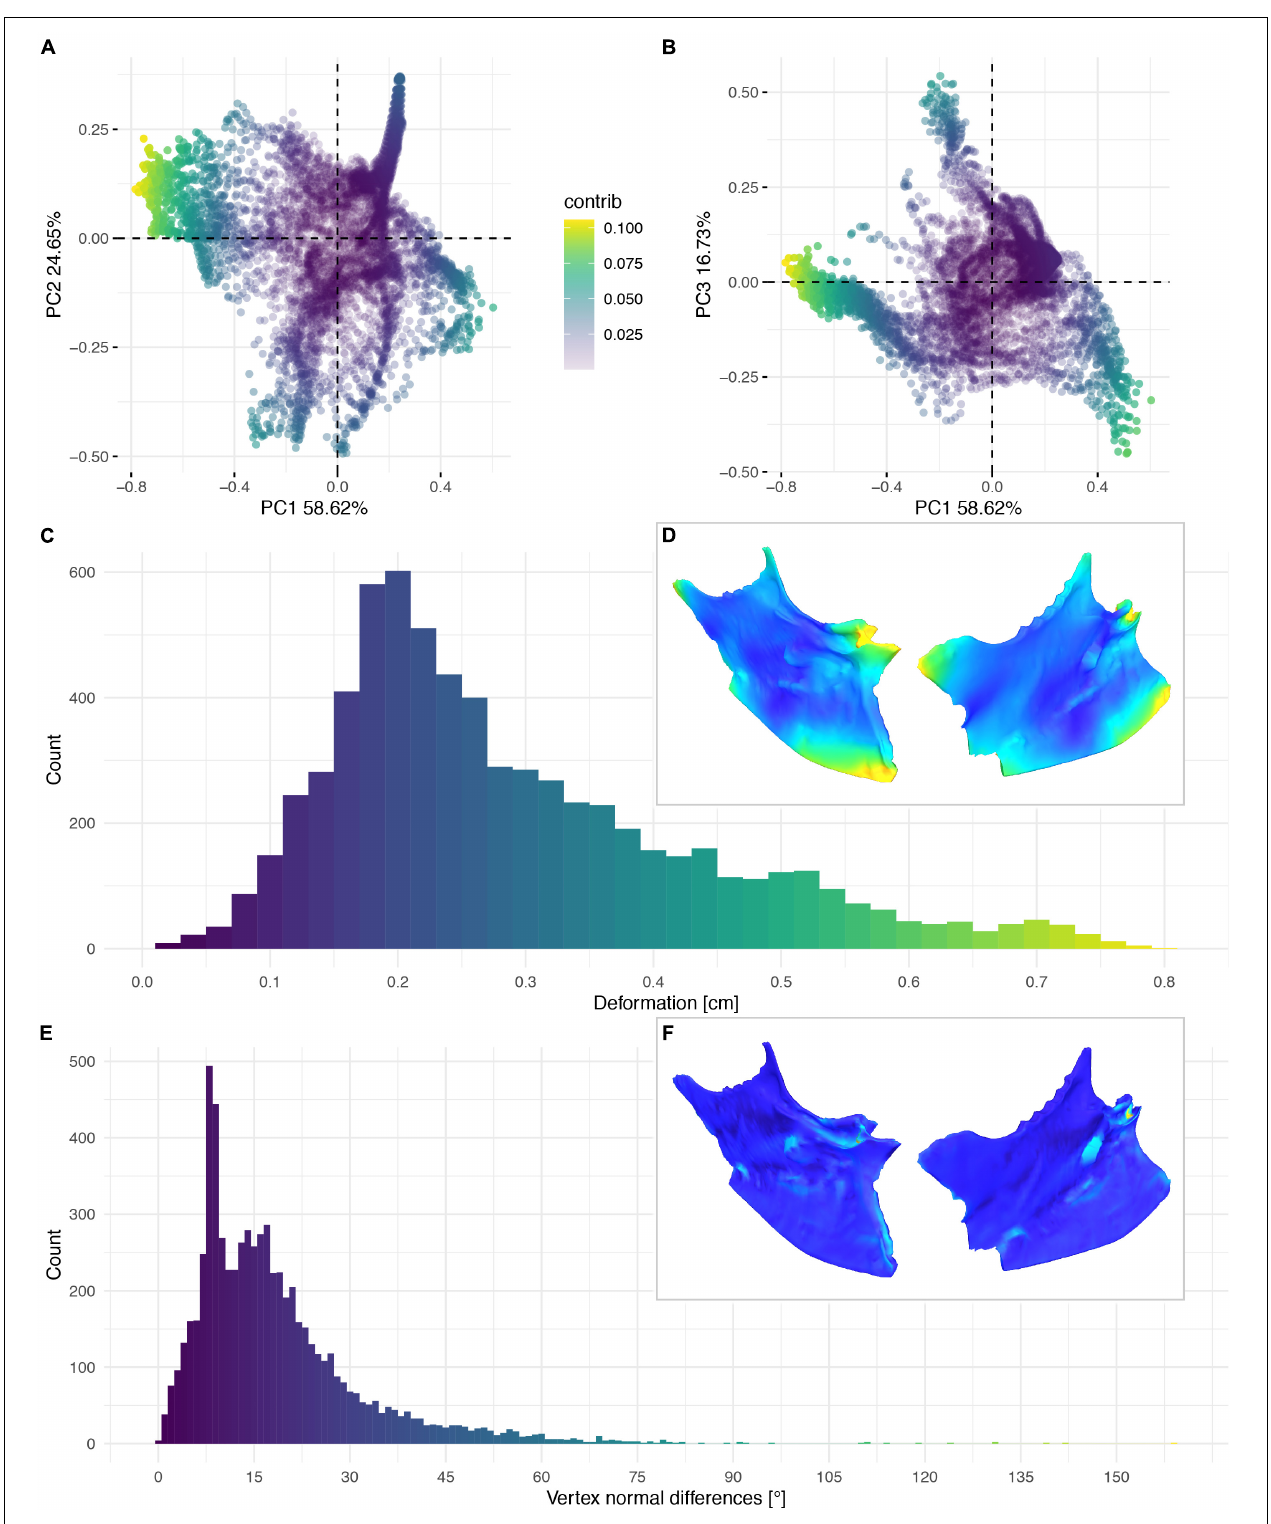
FIGURE 11 | Deformation of NHMUK PV A 905. PCA of the differences in the components of the vector between corresponding vertices (A,B) . PC1 represents the major axis of deformation. Histograms of the absolute deformation (morphological distance) between the reconstruction and the original specimen (C) and the angles between the different orientations of the corresponding vertex normals (E) . Visualisation of the deformations in oblique views (D,F) .